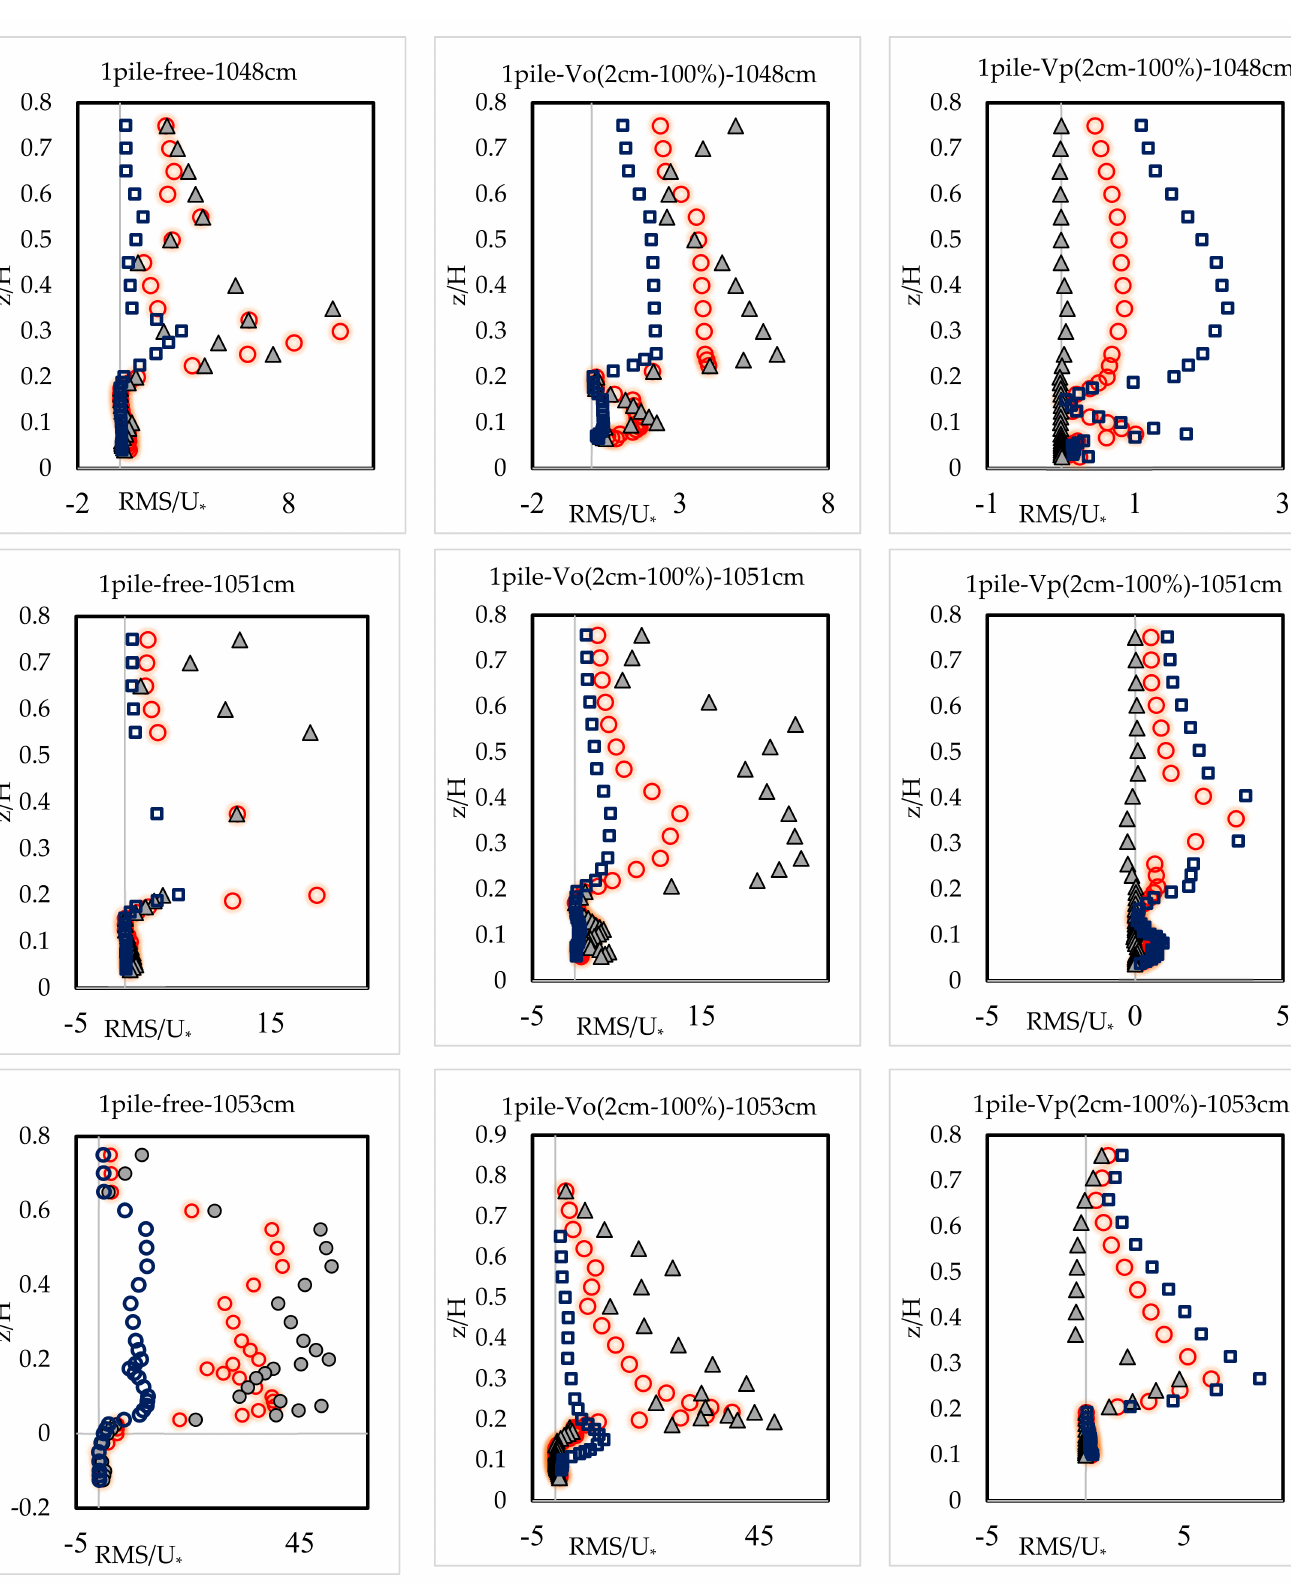
Figure 12. The vertical distributions of the longitudinal, latitudinal, and vertical turbulent intensity components normalized by shear stress in single pile